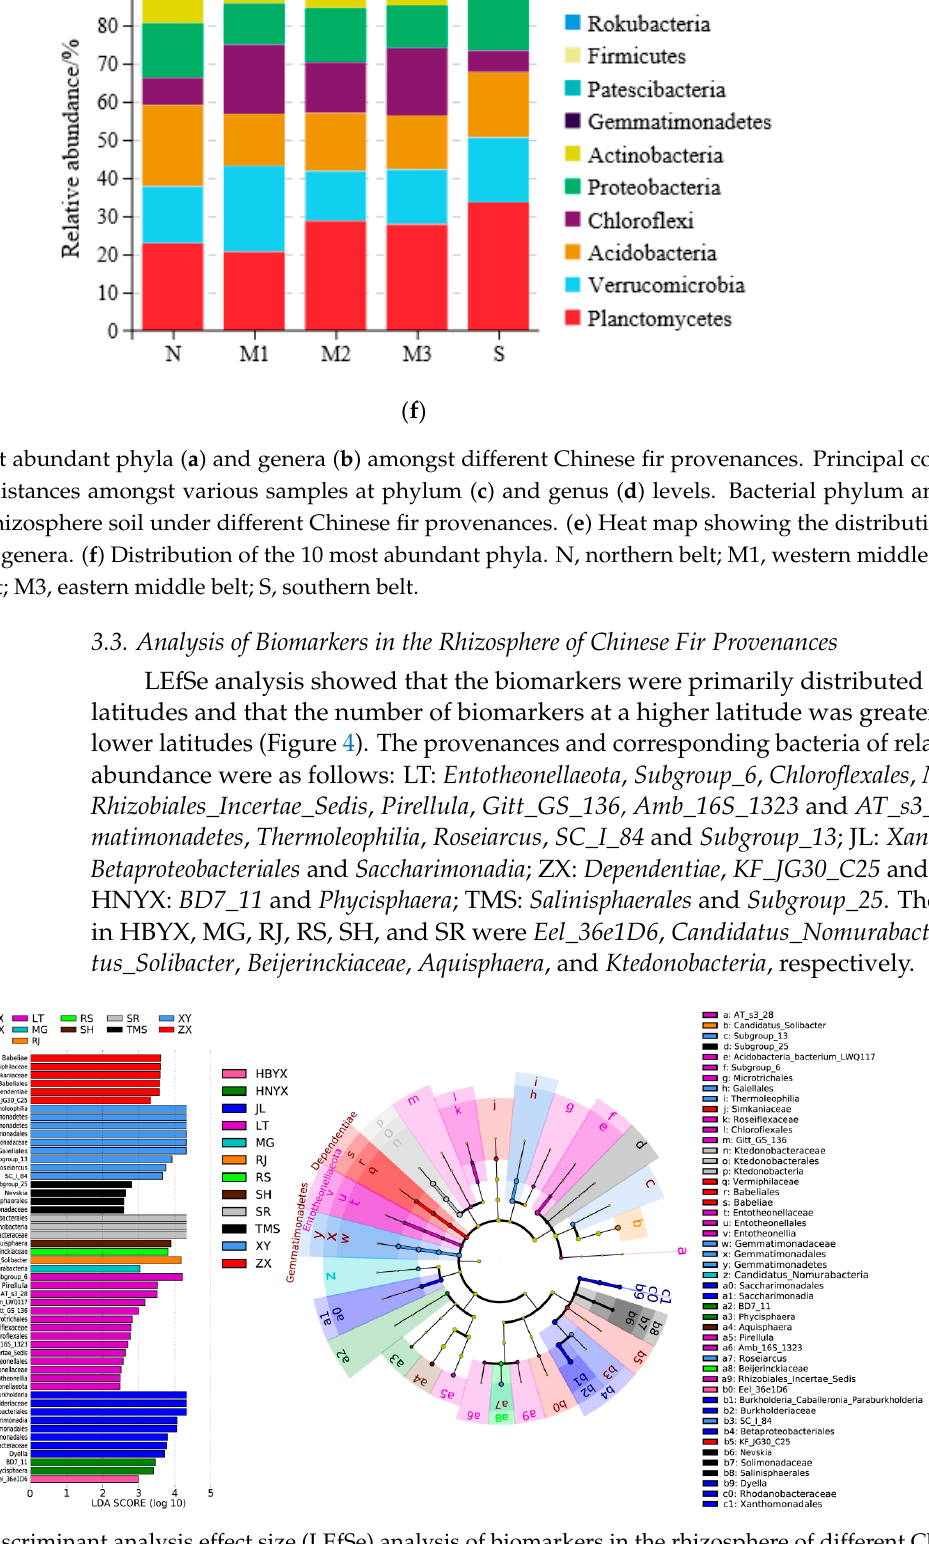
Figure 4. Linear discriminant analysis effect size (LEfSe) analysis of biomarkers in the rhizosphere of different Chinese fir provenances from domain to genus. Linear discriminant analysis (LDA) score = 2 was used to check biomarkers. The yellow node in the figure indicates no significant difference in the abundance of this bacterium at this level amongst different provenances; other node colors indicate that the abundance of bacteria in this provenance was significantly higher than that in other provenances ( p < 0.05).